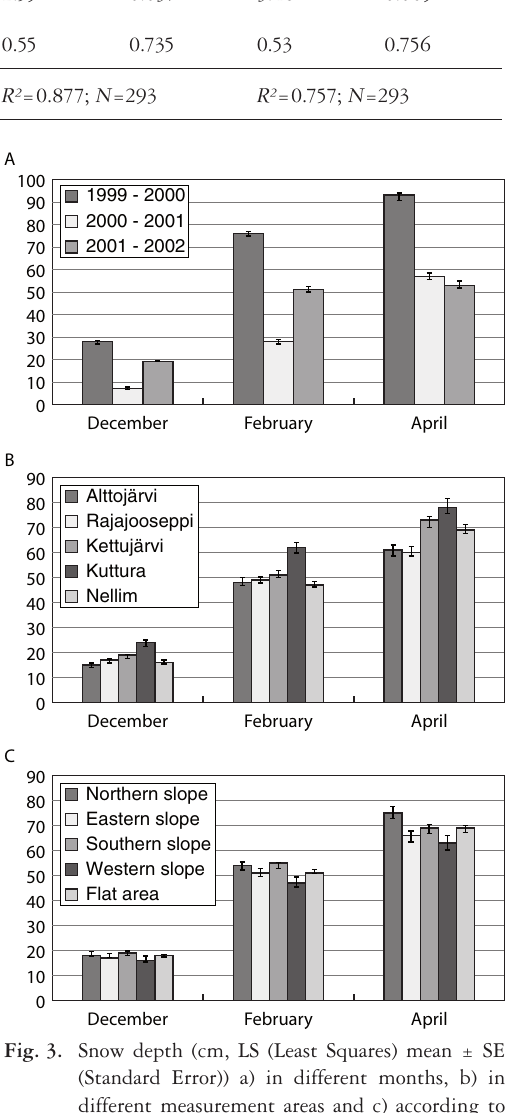
Fig. 3. Snow depth (cm, LS (Least Squares) mean ± SE (Standard Error)) a) in different months, b) in different measurement areas and c) according to the slope aspect during winters 1999 - 2002 in the Ivalo reindeer herding